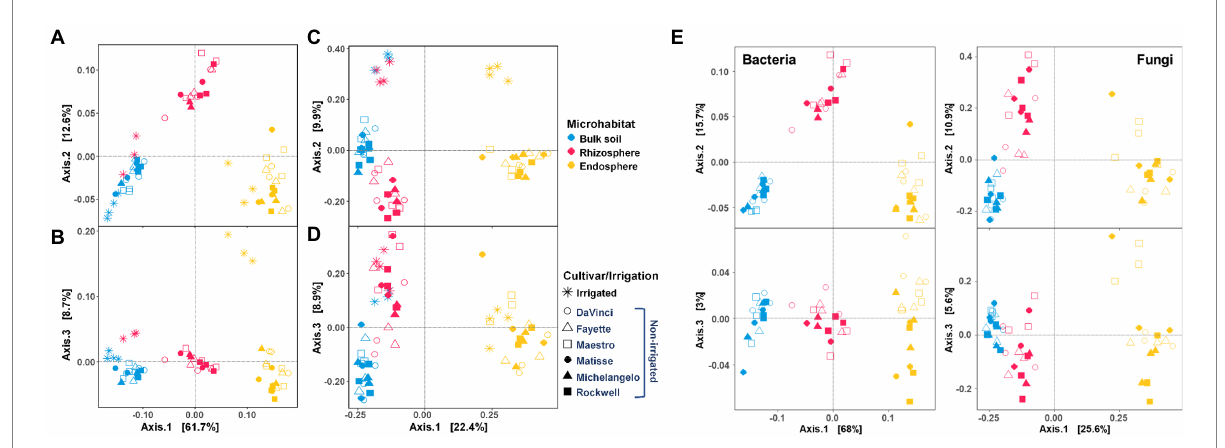
FIGURE 2 Principal coordinates analysis (PCoA) of bacterial (A,B) and fungal (C,D) communities in the bulk soil (blue), rhizosphere (pink), and root endosphere (yellow). The inset (E) is the PCoA of bacterial and fungal communities under no-irrigation only. Irrigation and cultivar treatments are indicated by symbols.